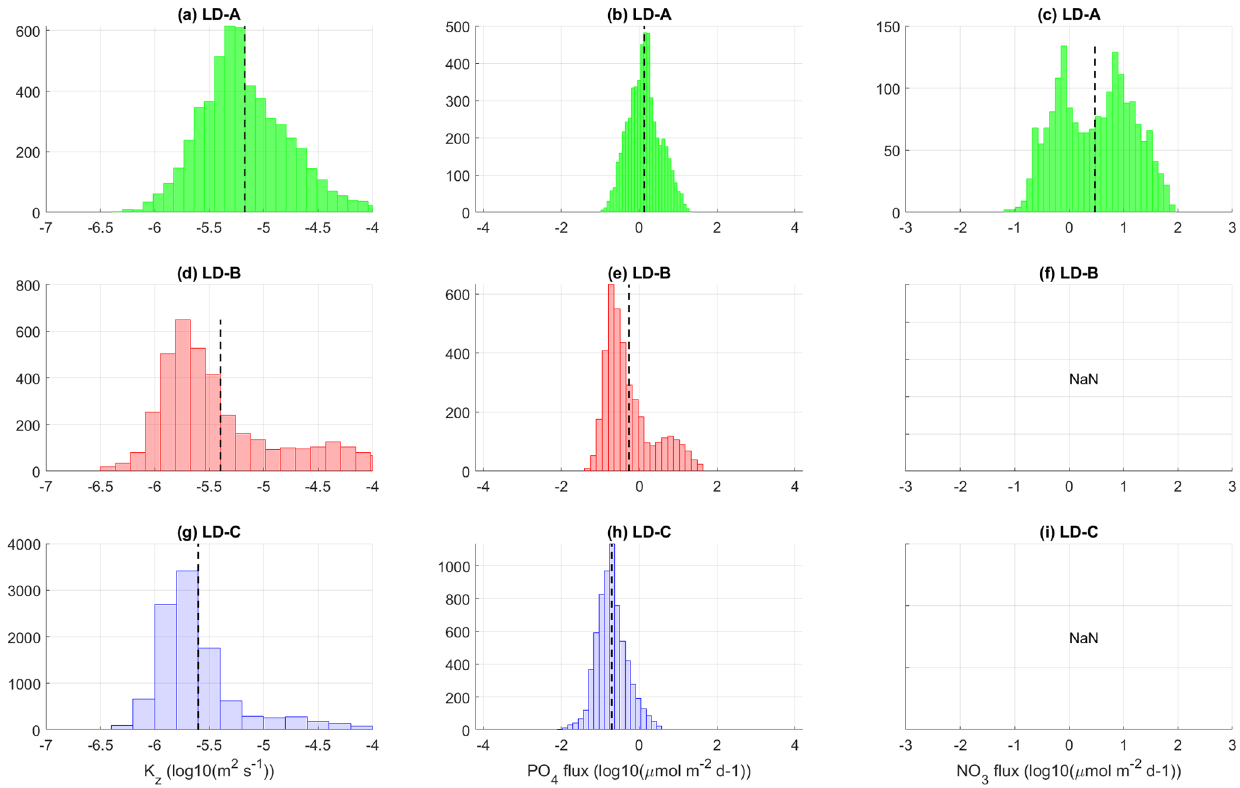
Figure 13. Histograms of K z (a, d, g) , phosphate (b, e, h) , and nitrate (c, f, i) turbulent diffusive fluxes at long-duration stations LD-A, LD-B, and LD-C within the photic layer (down to 70, 55, and 120m respectively). At LD-B and LD-C the nitrate turbulent diffusive flux is below the noise level within the considered depth interval (f, i) . The mean value is displayed with a dashed black line.